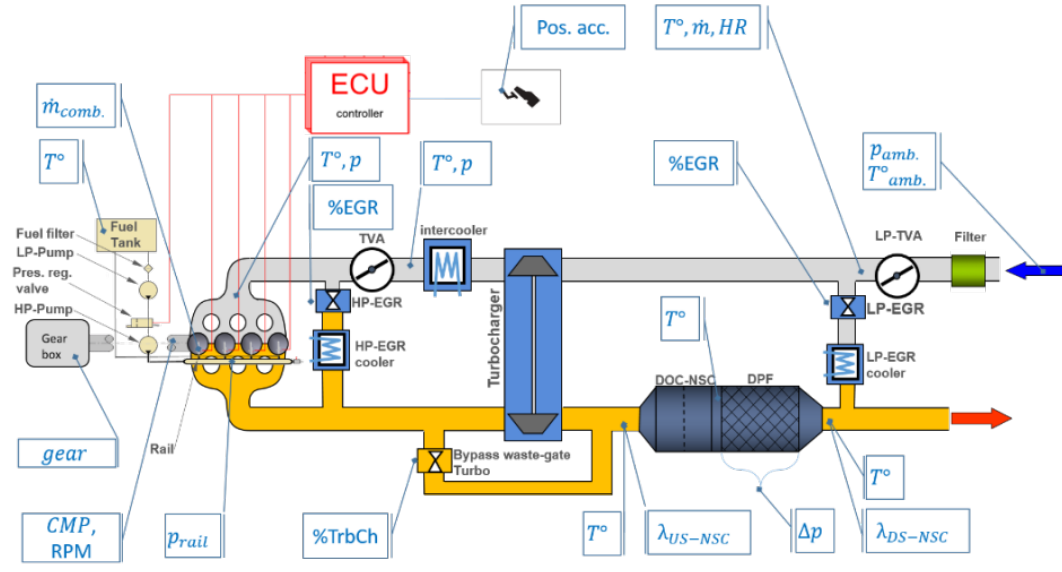
Figure 1. Layout schema of an internal combustion engine [1,2].